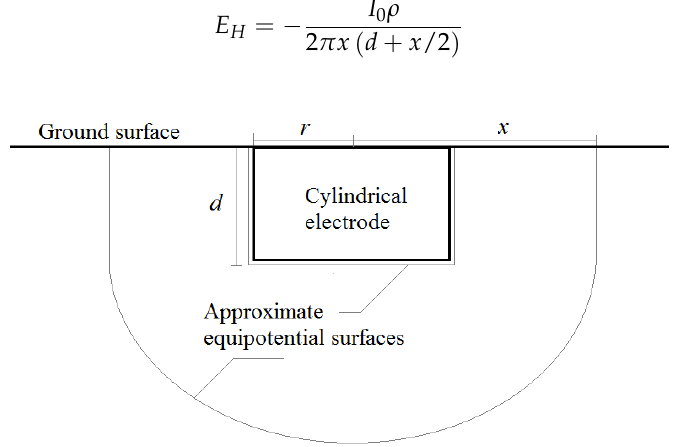
Figure 2. Cylindrical electrode and its approximate equipotential Figure 2 . Cylindrical electrode and its approximate equipotential surfaces.